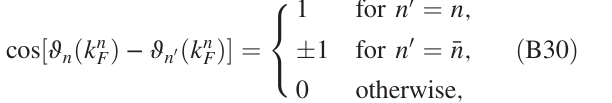
k Þ and its path with the increase in k n ð